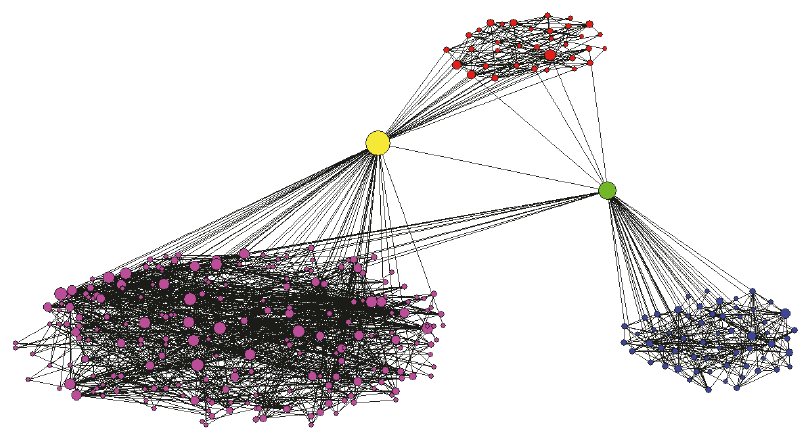
Figure 5: Diagram of two interactive forces of node mixing inside and among